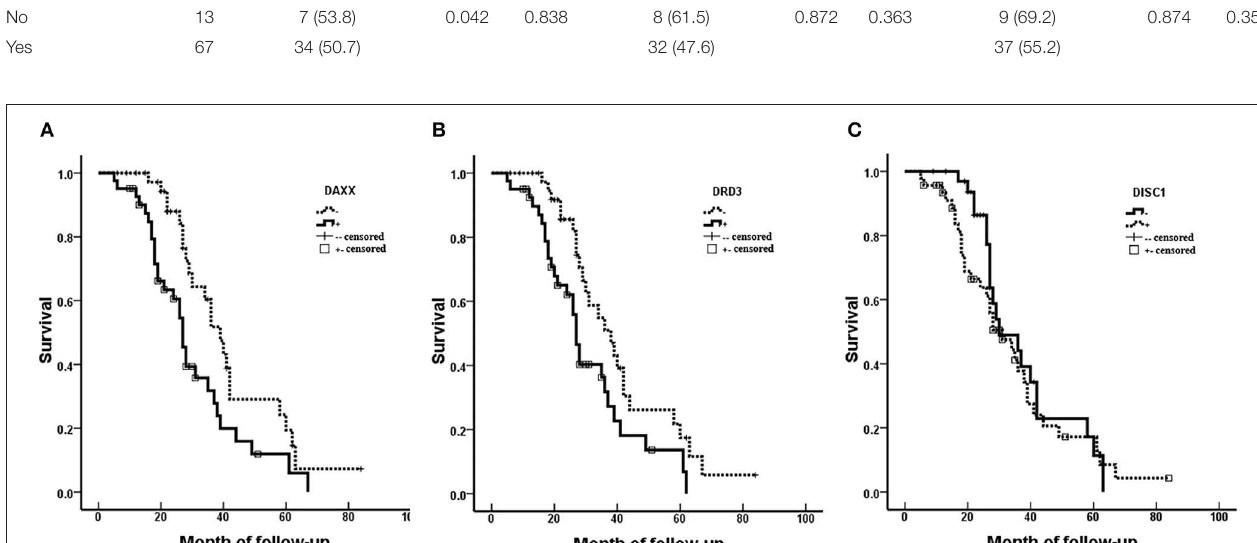
FIGURE 2 | Associations of DAXX, DRD3, and DISC1 expression with survival in patients with chondrosarcoma. Prognoses are depicted with Kaplan–Meier curves. (A) DAXX expression (mean survival, positive 30.41 vs. negative 42.13 months; P = 0.012). (B) DRD3 expression (mean survival, positive 30.87 vs. negative 40.85 months; P = 0.018). (C) DISC1 expression (mean survival, positive 34.09 vs. negative 37.34 months; P = 0.404).